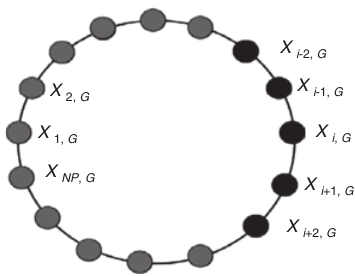
Figure 1: Neighborhood Ring